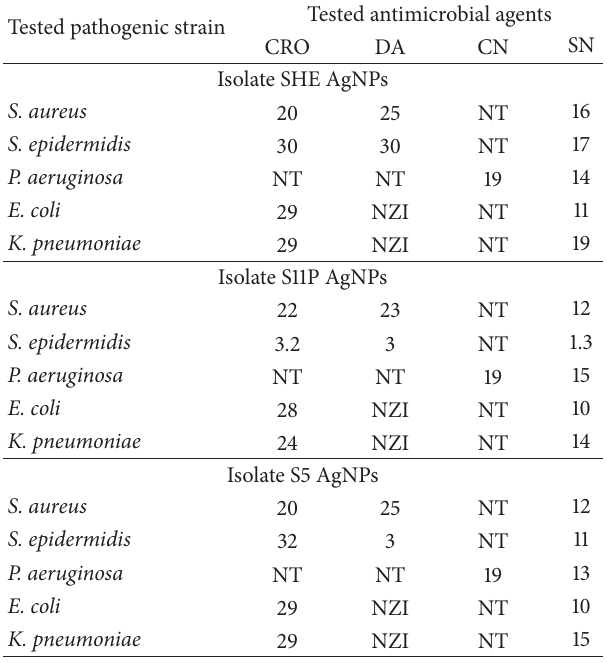
Figure4:Showingperiodicalcolorchangeoftheproducedcolloidal